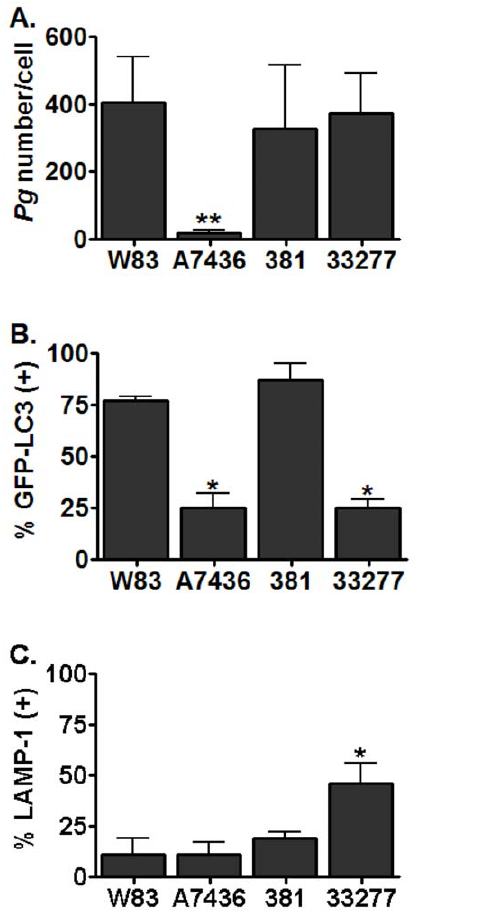
Figure 5. Number of internalized P.gingivalis in HCAE cells and their distribution in LC3 or LAMP-1 positive vacuoles. A) Mean number 6 SD of internalized bacteria. **Significantly less than other strains ( P , 0.0001). B) Mean percent 6 SD bacteria in LC3 positive vacuoles. *Significantly different from W83 and 381 ( P , 0.01). C) Mean percent 6 SD bacteria in LAMP-1 positive vacuoles. *Significantly different from other strains ( P , 0.02). All values were obtained from samples collected at 6 h post inoculation and represent three biological replicates obtained from three independent experiments.